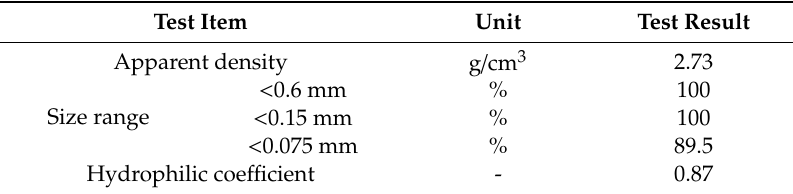
Table 2. Quality test results of the mineral powder.